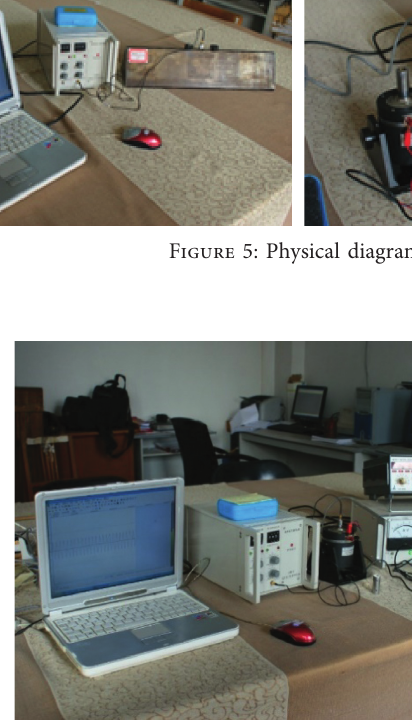
Figure 6: Calibration system.